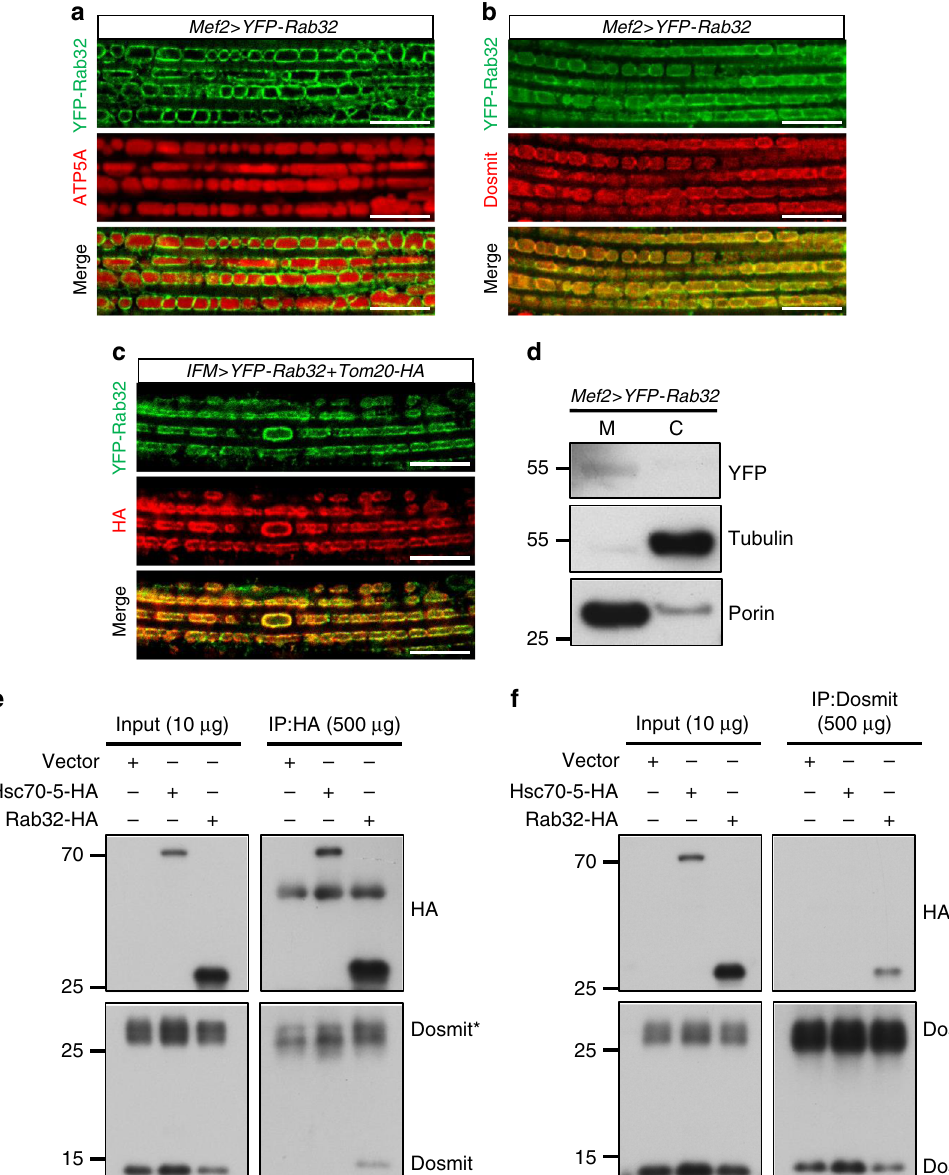
Fig. 8 The mitochondria-associated protein, Rab32, colocolized with Tom20-HA and undergoes a protein – protein interaction with Dosmit. a Confocal microscopy images of YFP-Rab32 (green) localized around mitochondria (red) and b colocalized with Dosmit (red) in fl y muscle tissue. Scale bars: 10 μ m. c Tom20-HA (red) ectopically expressed and colocalized with YFP-Rab32 (green). d Western blotting of fl ight-muscle tissue homogenates showed expression of the YFP-Rab32 protein in the mitochondrial fraction only (M: mitochondrial fraction; C: cytosolic fraction; Tubulin: cytosolic control; Porin: mitochondrial control). S2 cells transfected with Hsc70-5-HA or Rab32-HA plasmids. e When Rab32-HA or Hsc70-5-HA is immunoprecipitated with an anti-HA antibody, Dosmit can be detected in the Rab32-bound complex. f When endogenous Dosmit proteins are immunoprecipitated with the anti- Dosmit antibody, only Rab32-HA can be detected in the Dosmit – pulled-down complex. For the pull-down, 10 μ g of input was loaded. For SDS-PAGE, 500 μ g protein from the immunoprecipitation was loaded. Source data are provided as a Source data fi